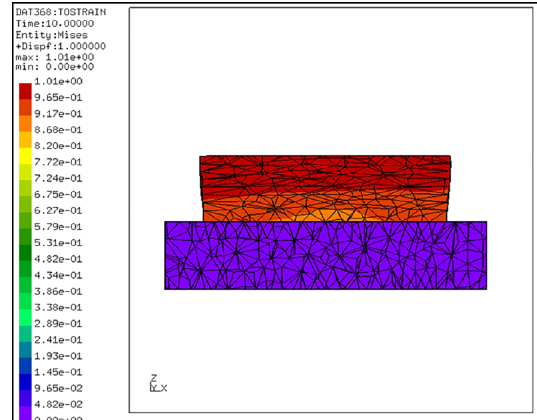
Figure 15. Cut view of the Von Mises Equivalent Strain for copper at 500 °C, tested under compression with a strain rate of 0.1s -1 , with a friction coefficient of 0.20, and a Poisson´s ratio of 0.34, at a time of 10